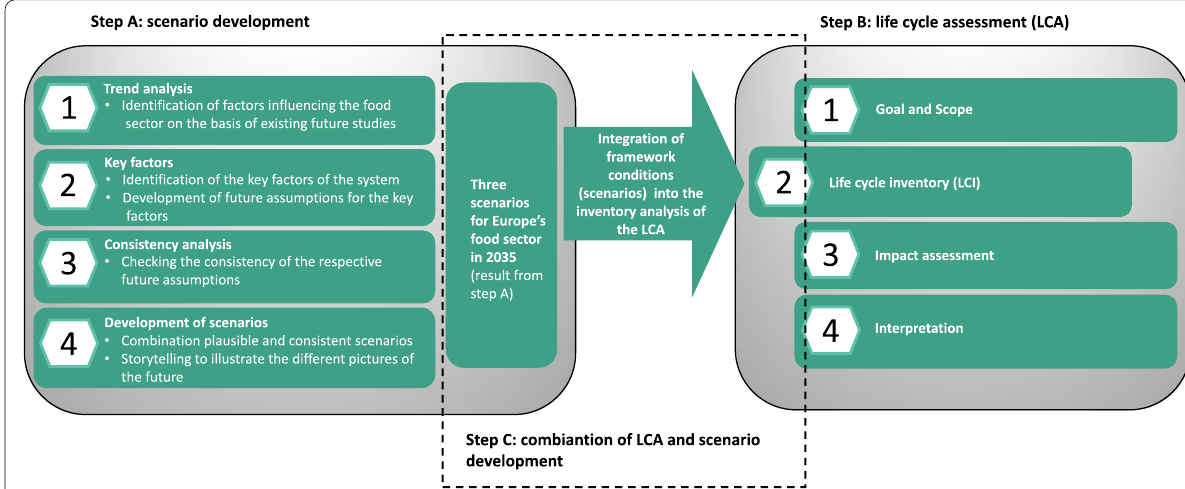
Fig. 2 Overview of the combination of qualitative scenarios and life cycle assessment (LCA) and their respective prior development steps (source: Own